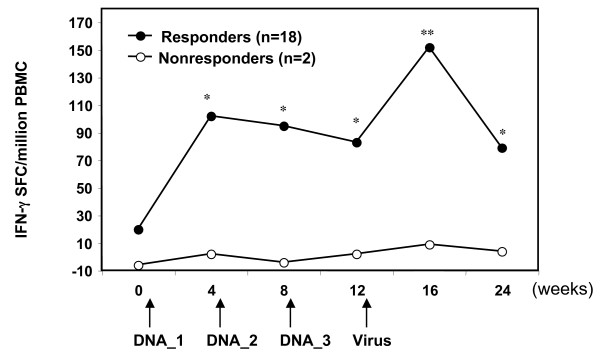
Antigen-specific IFN-γ responses against pre-erythrocytic antigen PfCSP. PBMC from PfCSP or CSLAM immunized monkeys (both PBS and CRL1005 formulations) were assayed against recombinant PfCSP protein by IFN-γ ELIspot. Results represent the mean net spot-forming cells (SFC) per million PBMC from all responders (n = 18) (solid circle) or non-responders (n = 2) (open circle) at the defined time points. DNA_1 = 1st DNA immunization; DNA_2 = 2nd DNA immunization; DNA_3 = 3rd DNA immunization; Virus = ALVAC-Pf7 boost. Net SFC was calculated by correcting the SFC responses with antigen for background SFC without antigen. IFN-γ ELIspot responses were classified as positive if (1) the net SFC (mean SFC in experiment antigen wells – mean SFC in medium wells) was > 25 SFC per million PBMC, and (2) the stimulation index (ratio of mean SFC in experimental peptide wells to mean SFC in medium wells) was > 2. (*p < 0.05 and **p < 0.01).